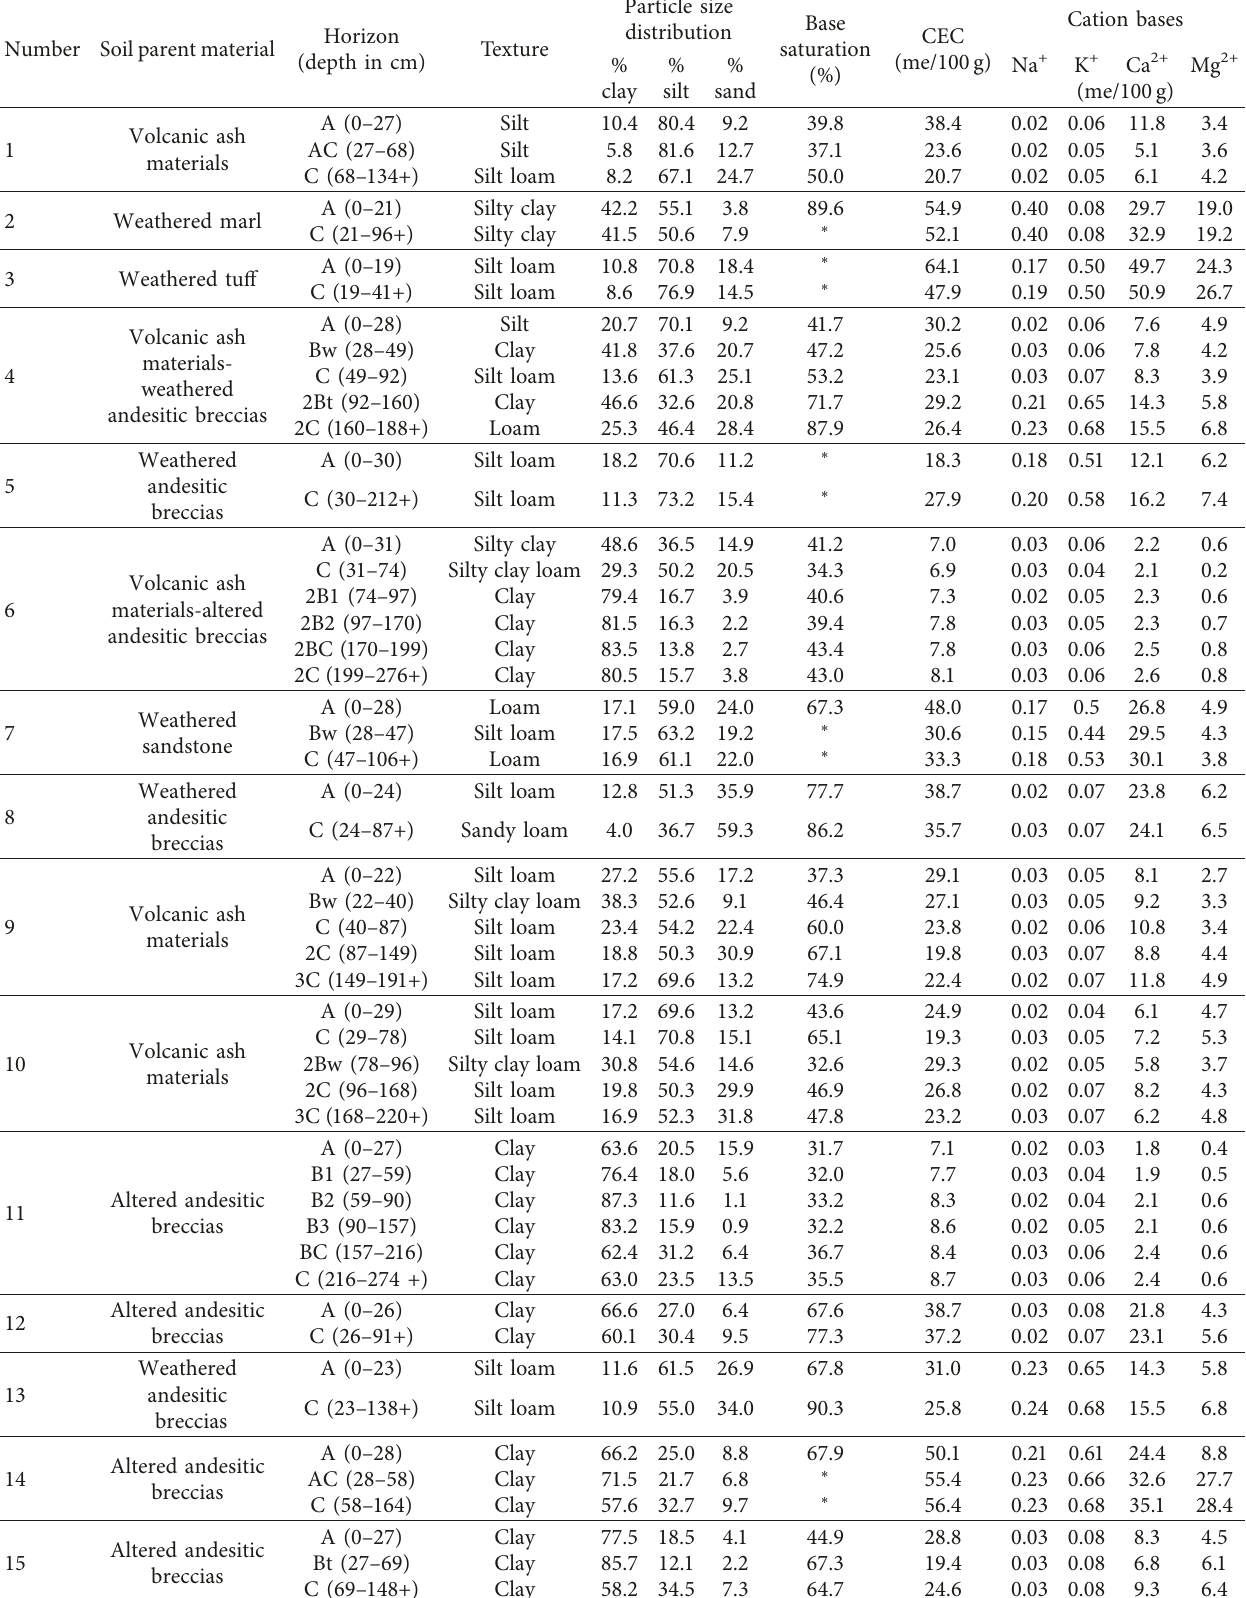
Table 1: Physicochemical properties of